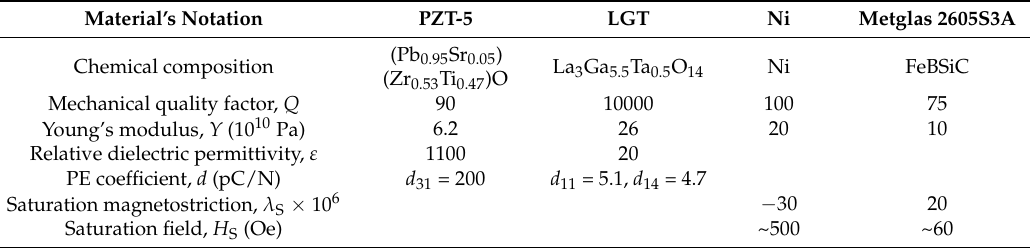
Table 1. Physical properties of piezoelectric (PE) and ferromagnetic (FM)